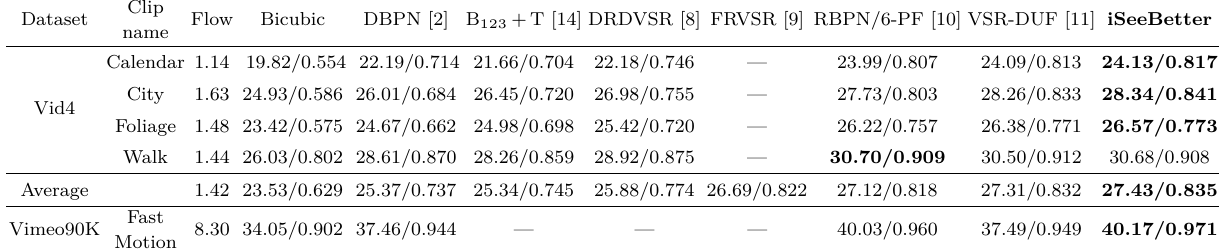
Table 3 SNR/SSIM evaluation of state-of-the-art VSR algorithms using Vid4 and Vimeo90K for 4 × upscaling. Bold numbers indicate best performance Dataset